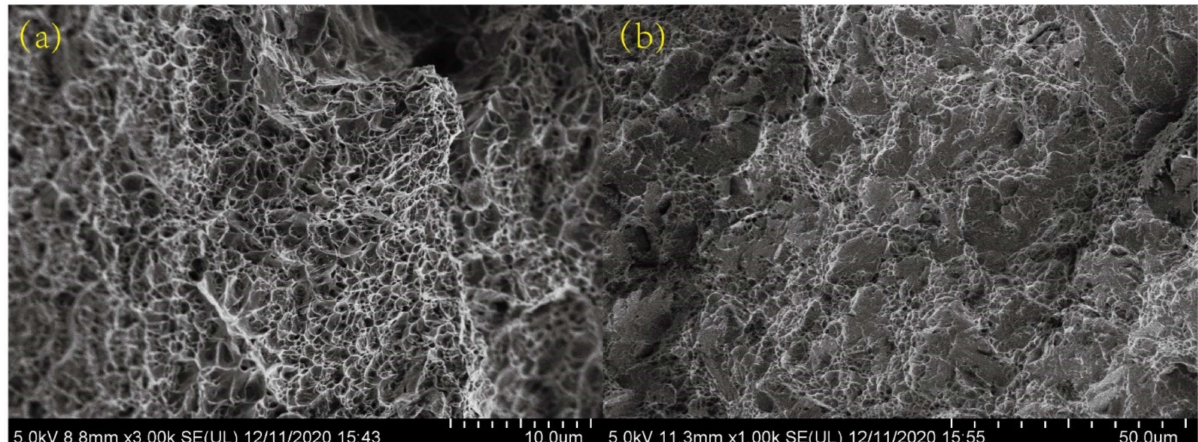
Figure 7. Tensile fracture morphology of samples No. 5 # : ( a ) base materials (BM); ( b )